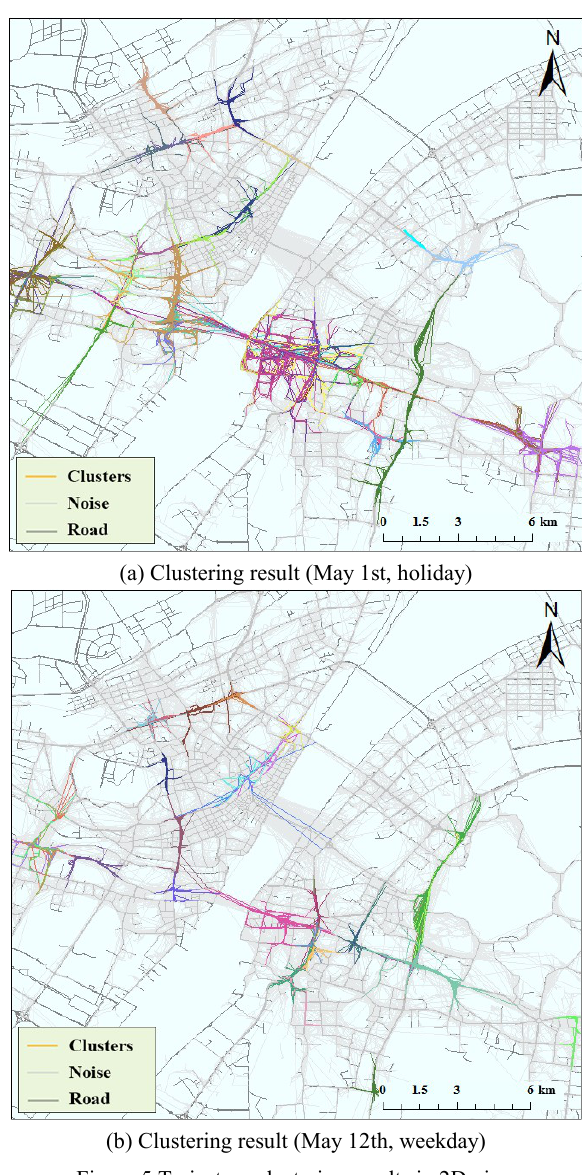
Figure 5 Trajectory clustering results in 2D